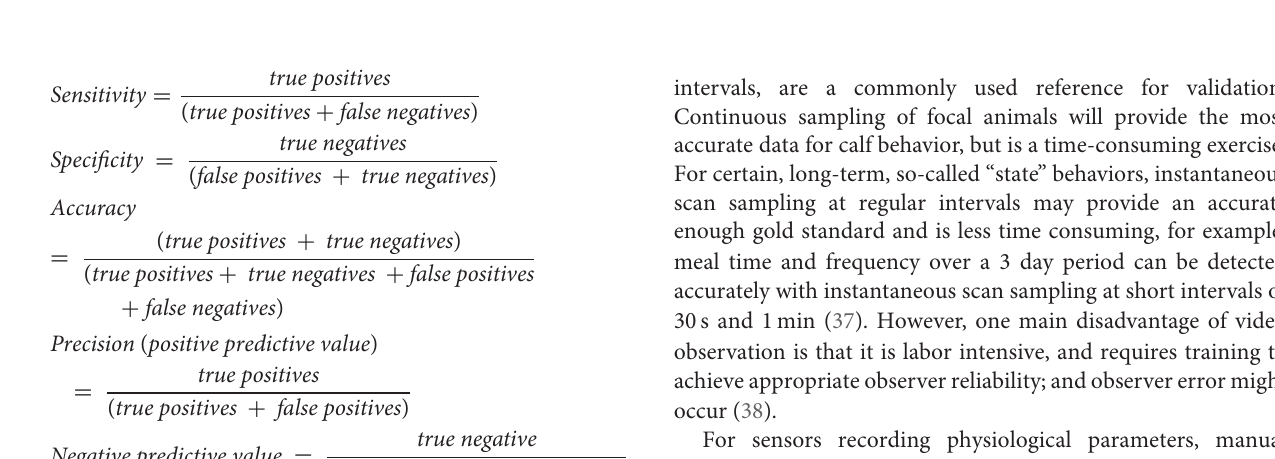
FIGURE 3 | Distribution of stages of included articles. *In Studds et al. (56) both diarrhea and navel inflammation were